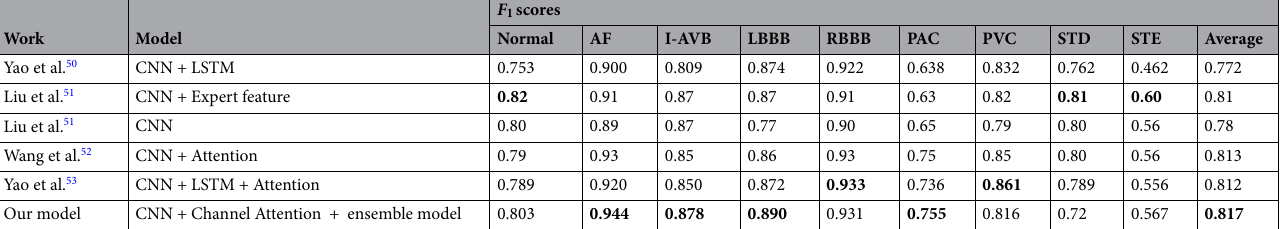
Table 6. Comparison for classification performance of previous works and ours evaluated on the CPSC2018 hidden test set. Significant values are in